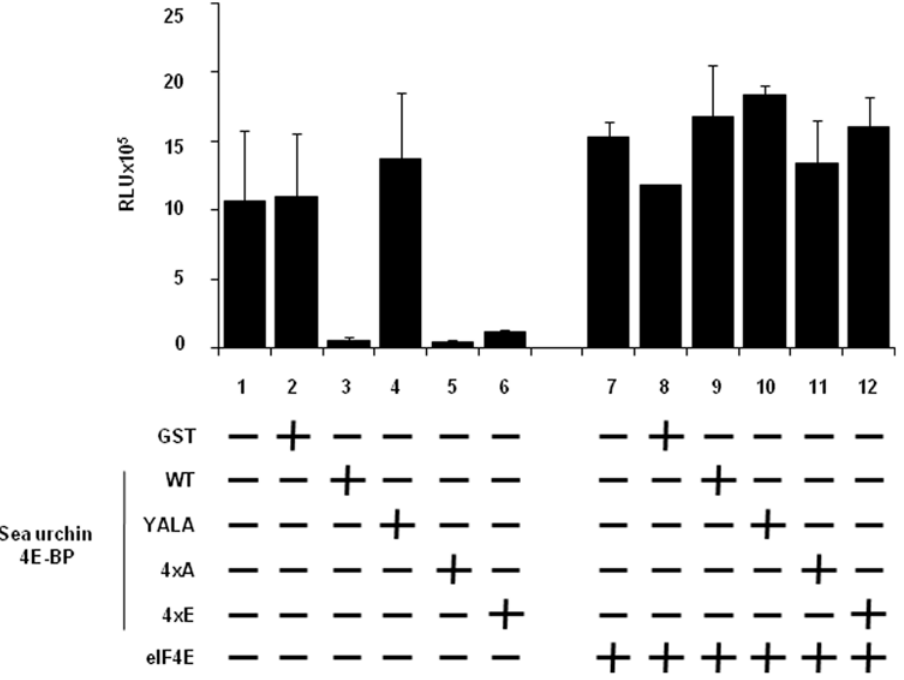
Figure 5. Translation inhibition is rescued by GST-mIF4E. 200 ng of GST recombinant proteins (GST, GST-Sg4E-BP WT (WT), GST-Sg4E-BP YALA (YALA), GST-Sg4E-BP 4xA (4xA), GST-Sg4E-BP 4xE (4xE)) were added to the fertilized cell-free translation system with (lanes 8–12) or without (lanes 2– 6) a 5 min pre-incubation with 500 ng of GST-mIF4E (eIF4E) and Luciferase activity was measured as described in Materials and Methods after addition of a cap mRNA encoding Renilla Luciferase. The Luciferase activity is represented in RLU (Relative Light Units). Error bars represent the standard deviation (s.d.) of duplicates.